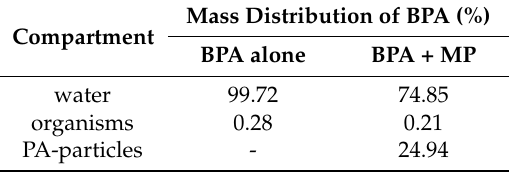
Table 1. Mass distribution of bisphenol A (BPA) for all relevant compartments in the test system calculated for BPA alone and BPA in combination with microplastics (MP) (treatment BPA + MP).